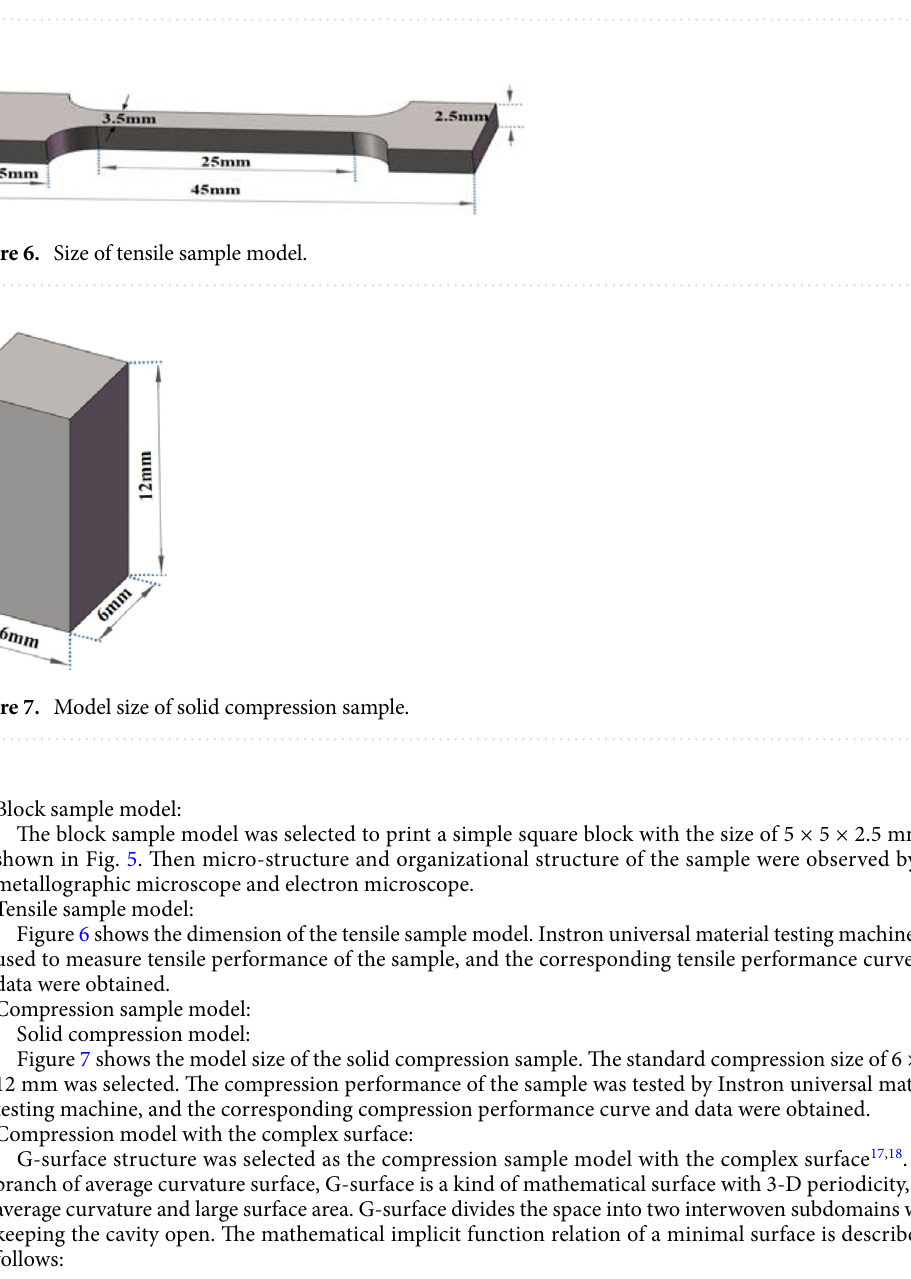
Figure 5. Size of metallographic sample model.